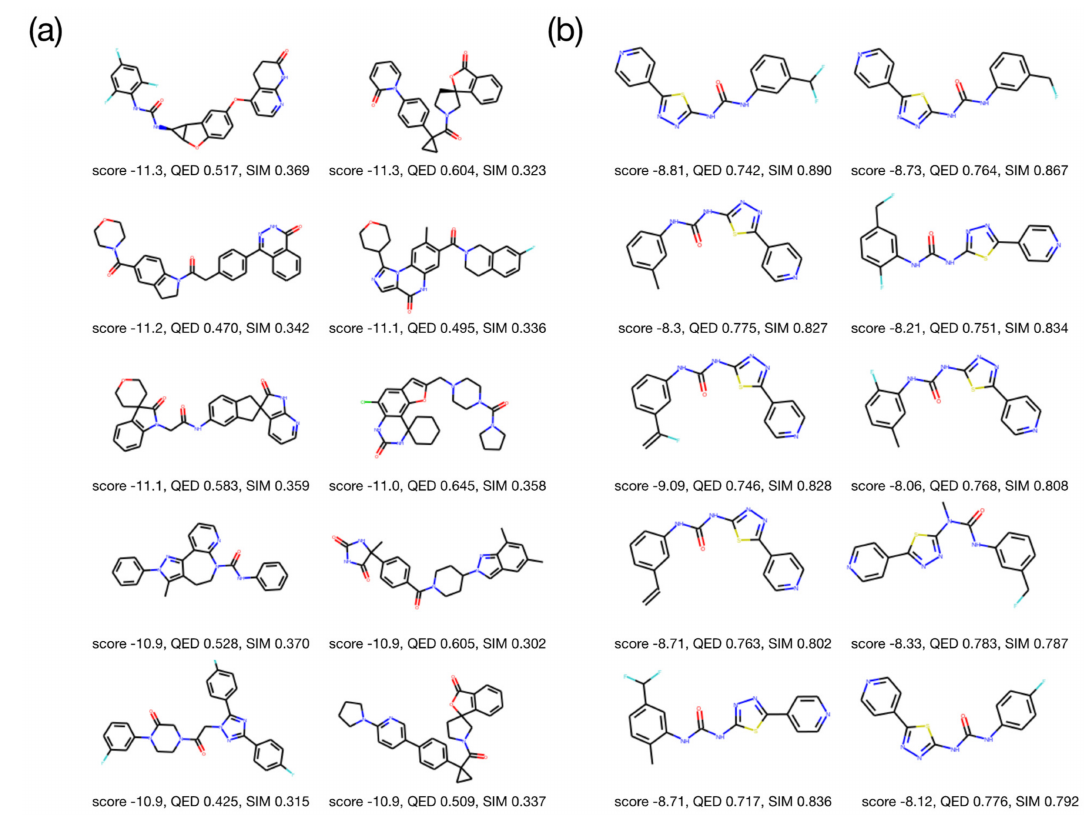
Figure 4. Comparison of existing and generated molecules. ( a ) The ten molecules with the lowest docking energy in the SureChEMBL dataset passed Lipinski’s rule of five. ( b ) The best ten molecules generated by MolFinder. The generated molecules are more similar to ML216 than the known molecules, with high QED and low docking energy values.